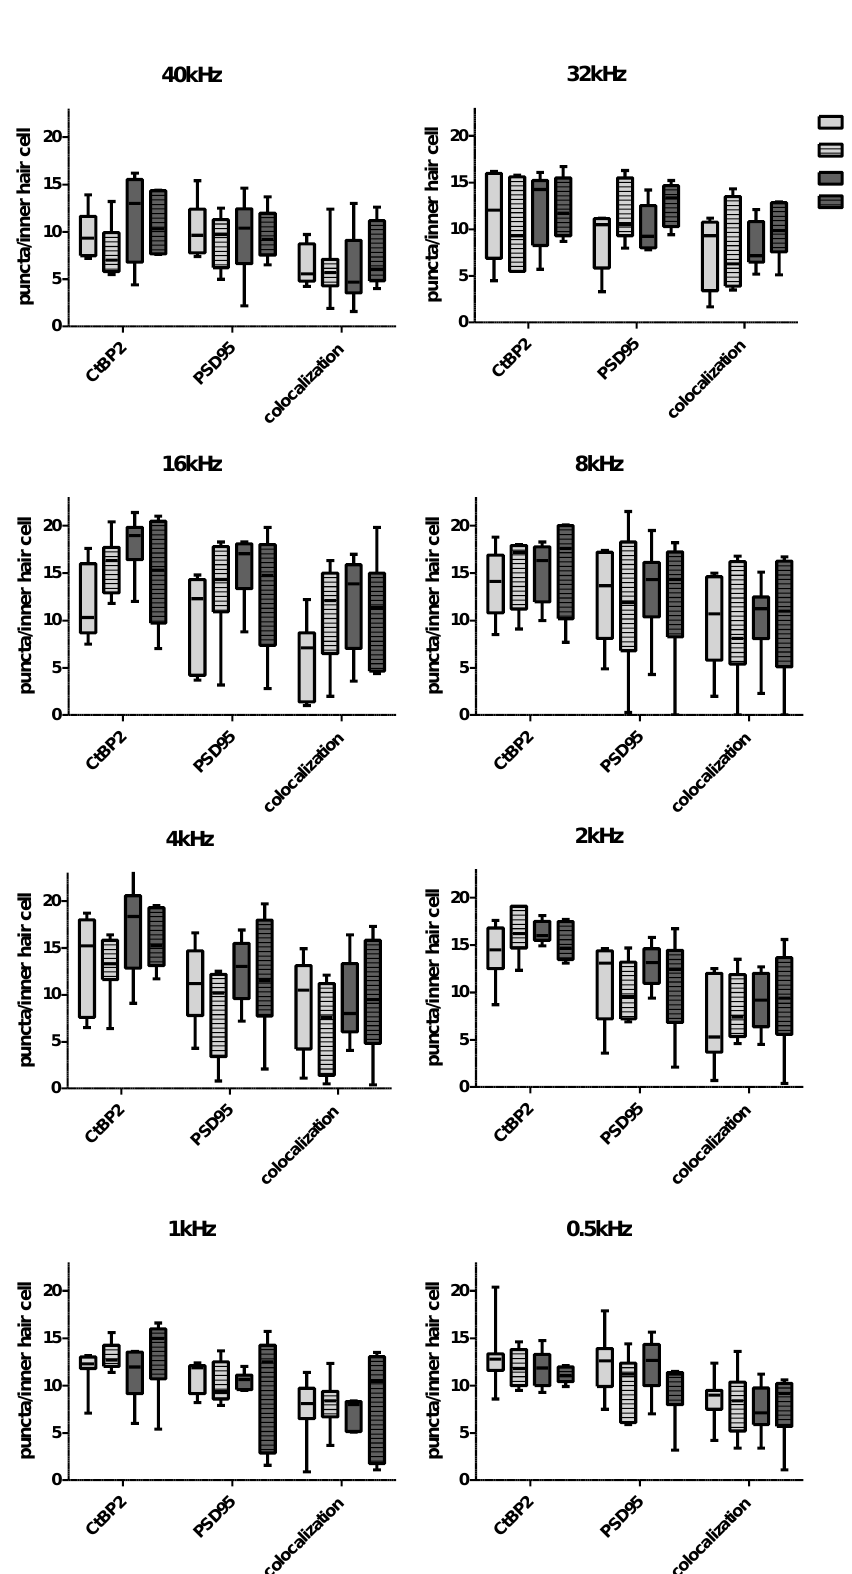
Figure 7. Synaptic counts per inner hair cell according to the corresponding frequency. Both CtBP2 and PSD95 puncta were counted individually. In addition, colocalized puncta in which the staining of CtBP2 and PSD95 overlapped were counted. Boxes display the mean and bars indicate the standard